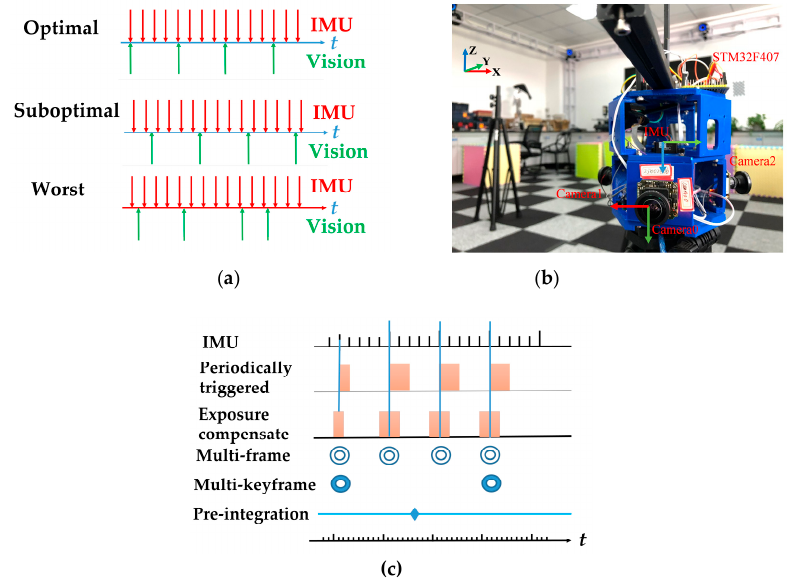
Figure 4. Sensor Synchronization and Data Acquisition. ( a ) Different conditions of synchronization and timestamps of sensors; ( b ) the hardware configuration and synchronization scheme in this work. The STM32F407 was used to ensure the synchronization between IMU and multiple fisheye cameras. The STM32F407 calculates precise (millisecond) timestamps for each IMU measurement (200 Hz). At certain timestamps (20 Hz), it will trigger the multiple fisheye cameras to capture new images (i.e., the IMU triggers the multiple fisheye cameras through STM32F407). According to the method in References [49,50], the accurate timestamp of multiple fisheye cameras will be got through adding half the exposure time to the IMU’s timestamps. ( c ) The principle of hardware synchronization method with exposure